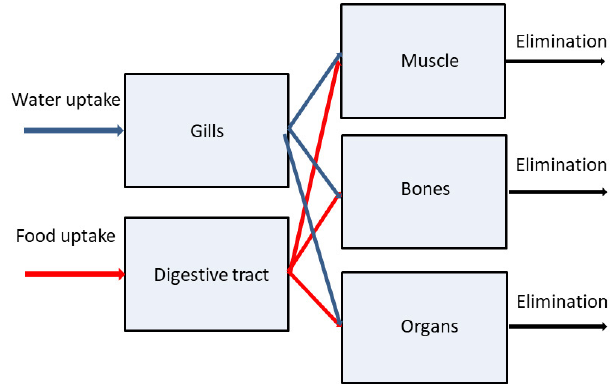
Figure 2. Schematic of the multi-compartment kinetic–allometric